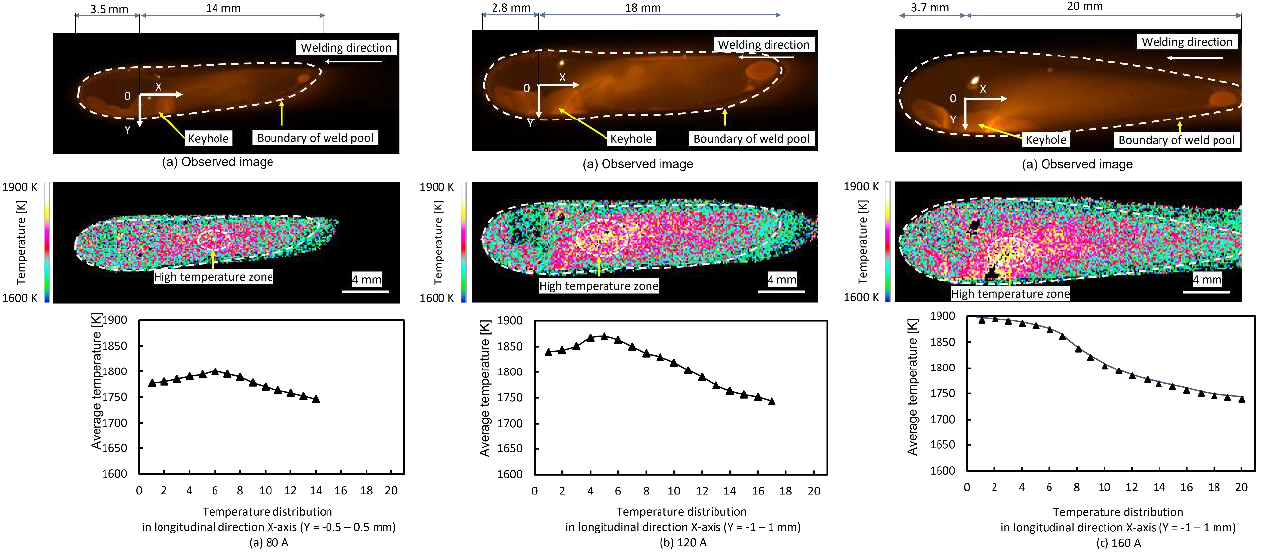
Figure 5. Temperature field on the melted domain surface: ( a ) for 80 A; ( b ) for 120 A; and ( c ) for 160